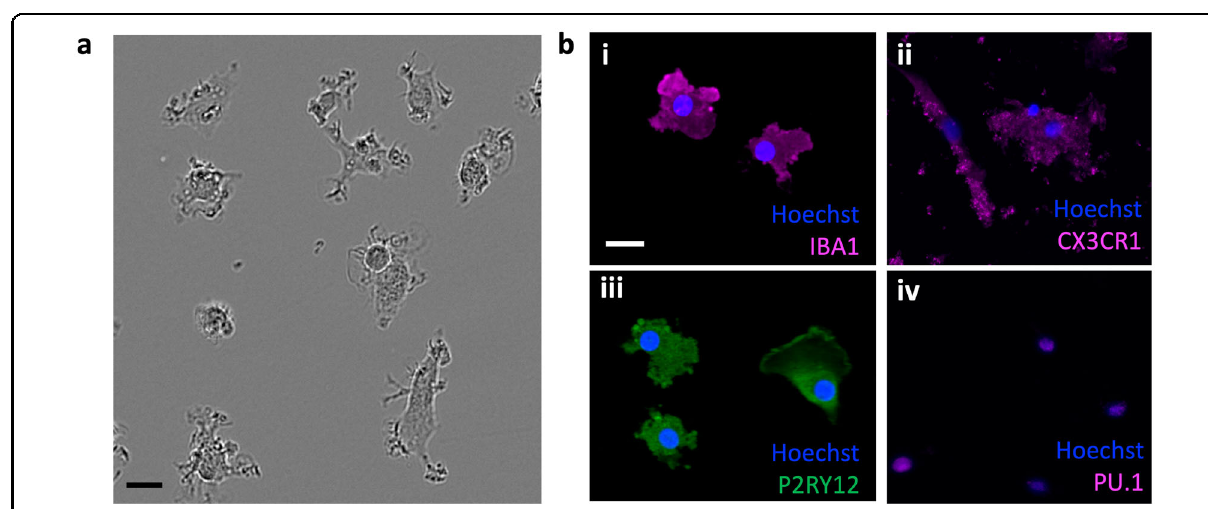
Fig. 4 Phenotypic characterization of CB-iMGs derived from CB-MNCs exposed to maternal SARS-CoV-2 infection. a Phase contrast rami fi ed morphology of patient-derived CB-iMGs. Scale bar: 30 μ m. b Immunostained images of exposed CB-iMG cells with nuclei (Hoechst) and indicated microglial markers (i) IBA1, (ii) CX3CR1, (iii) P2RY12, and (iv) PU.1. Scale bar: 25 μ m.